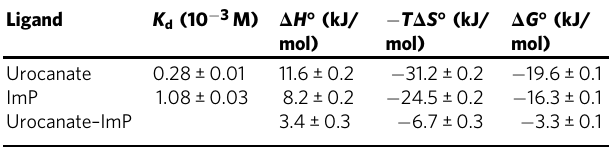
Table 2 Binding thermodynamics from